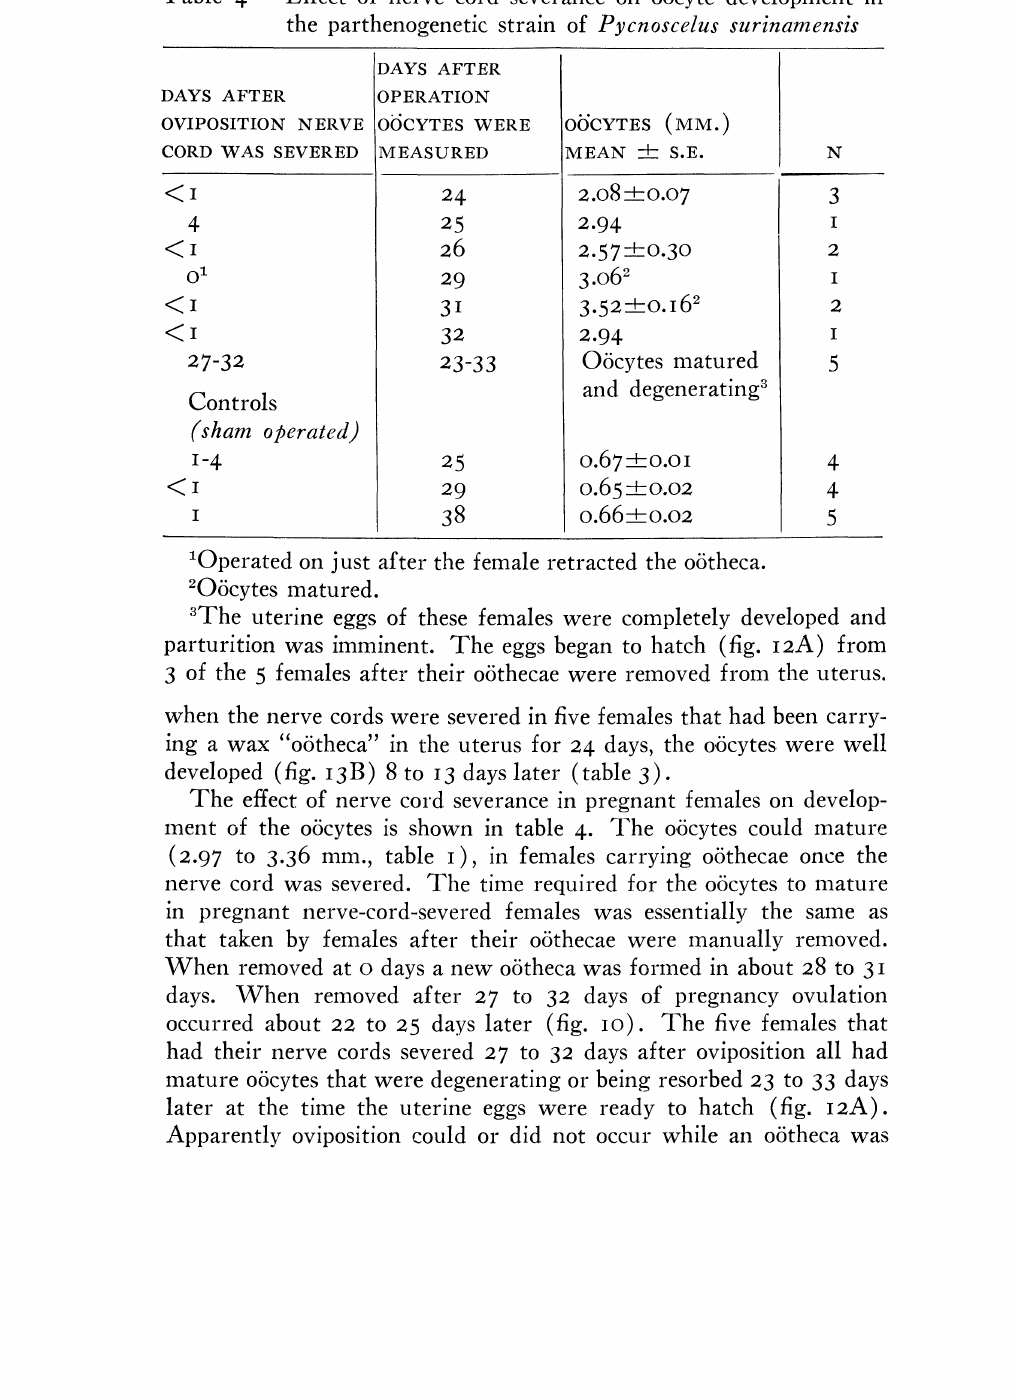
Table 4--Effect of nerve cord severance on o6cyte development in the parthenogenetic strain of Pycnoscelus